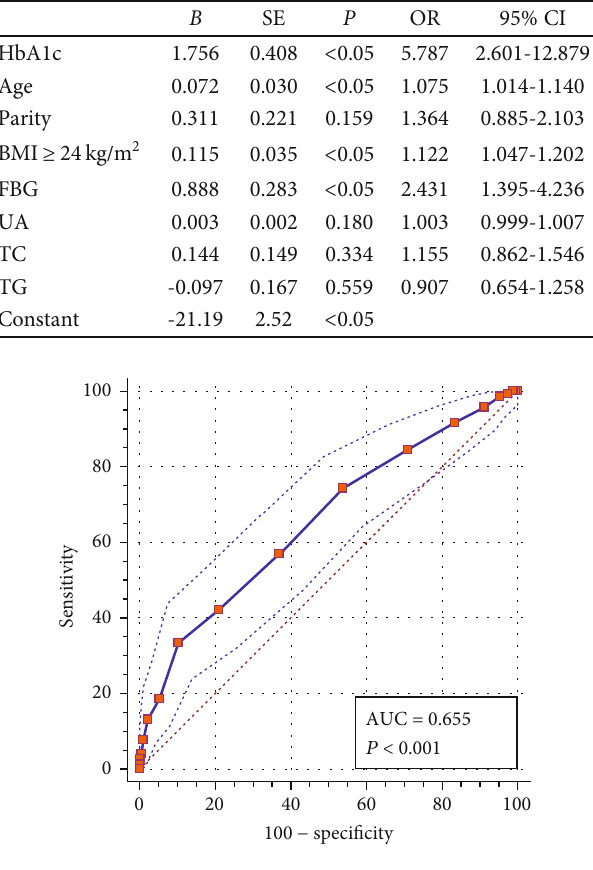
Figure 1: The ROC curve of fi rst-trimester HbA1c level in the diagnosis of GDM in